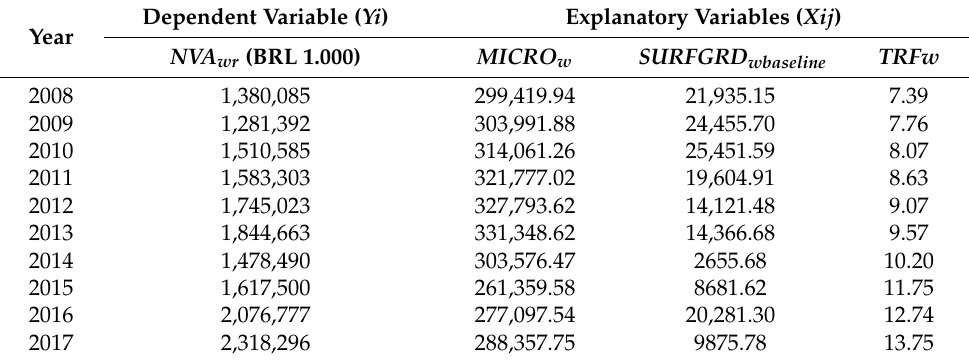
Table 4. Values of the dependent and explanatory variables for the water sector NVA model regression. Dependent Variable ( Yi